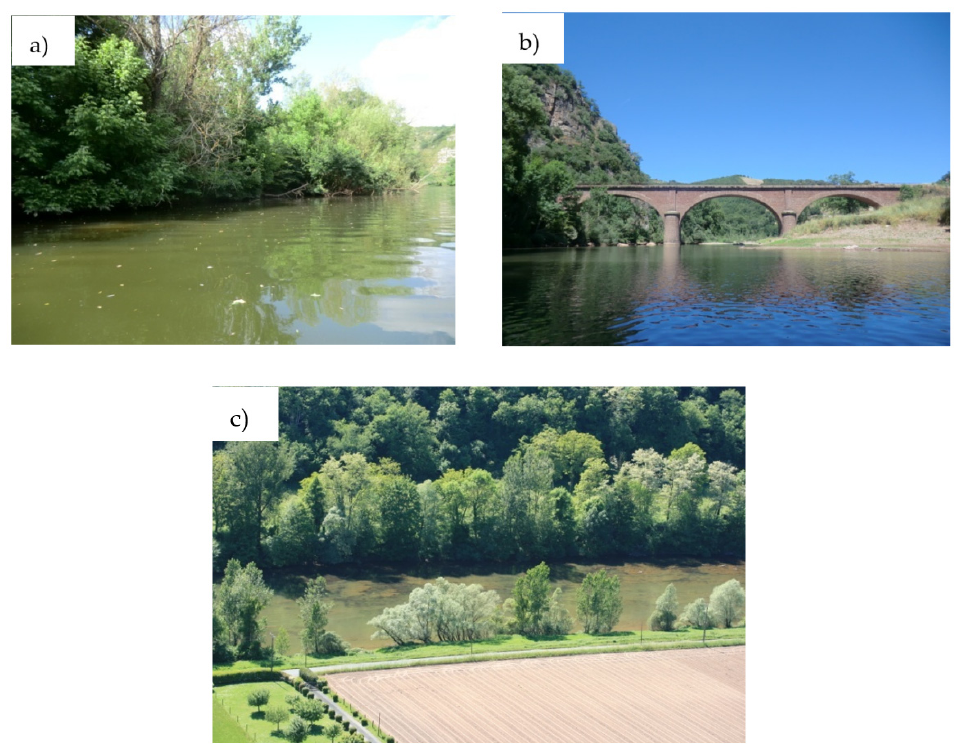
Figure 2. Overview of the three rivers sampled: ( a ) Dourdou de Camarès, ( b ) Lot, and ( c ) Tarn.